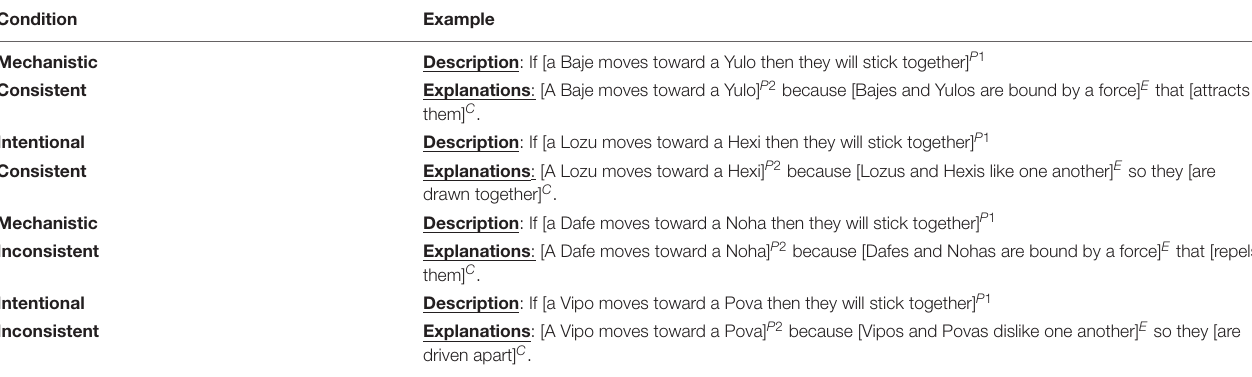
TABLE 1 | Samples of syllogisms modified with mechanistic and intentional explanations.